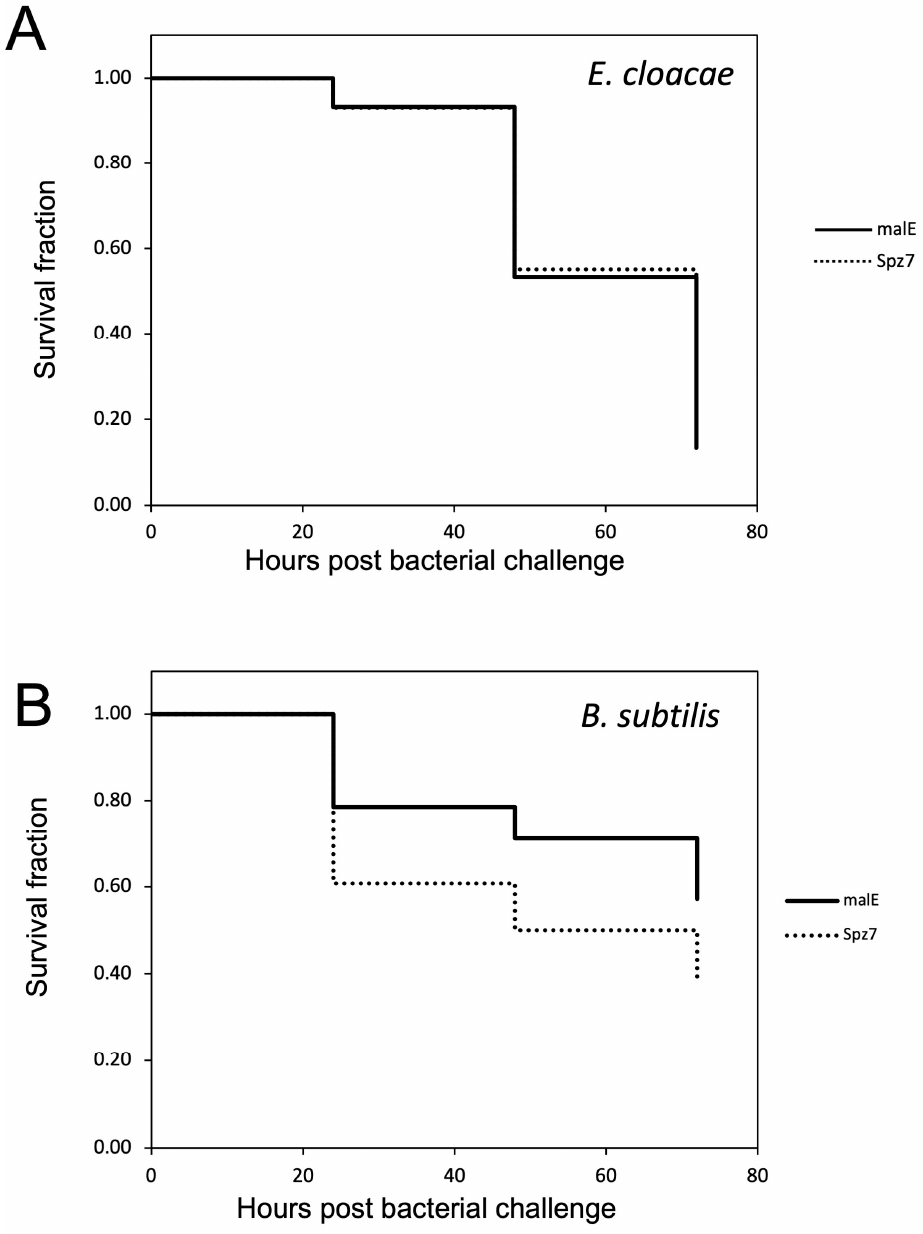
Figure 13. Effects of spz7 knockdown on host defense against two model bacterial pathogens, E. cloacae ( A ) or B. subtilis ( B ). The survival of pupae was monitored and recorded every 24 h. The procedure of the assay was the same as that presented in Figure 7 . There was no significant difference in survival between control (malE dsRNA- treated) and spz7 knockdown pupae ( p > 0.05, according to the Gehan–Breslow–Wilcoxon test).